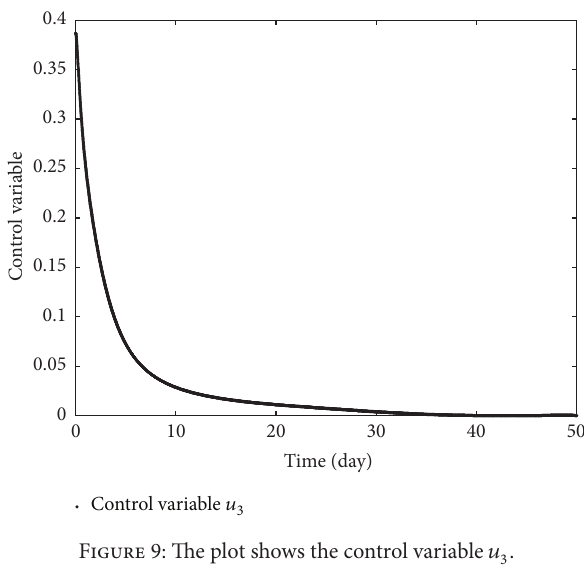
Figure 9: The plot shows the control variable 𝑢 3